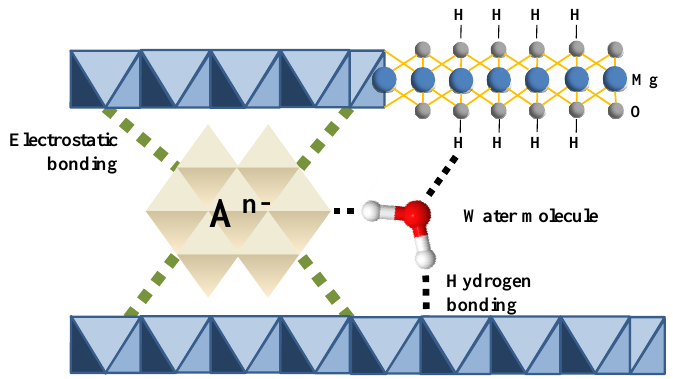
/ LDH. Adapted from Ref. [15], Copyright 2013, Figure 4. Structural representation of a POM/LDH. Adapted from Ref. [15], Copyright 2013, Elsevier. Figure 4. Structural representation of a POM